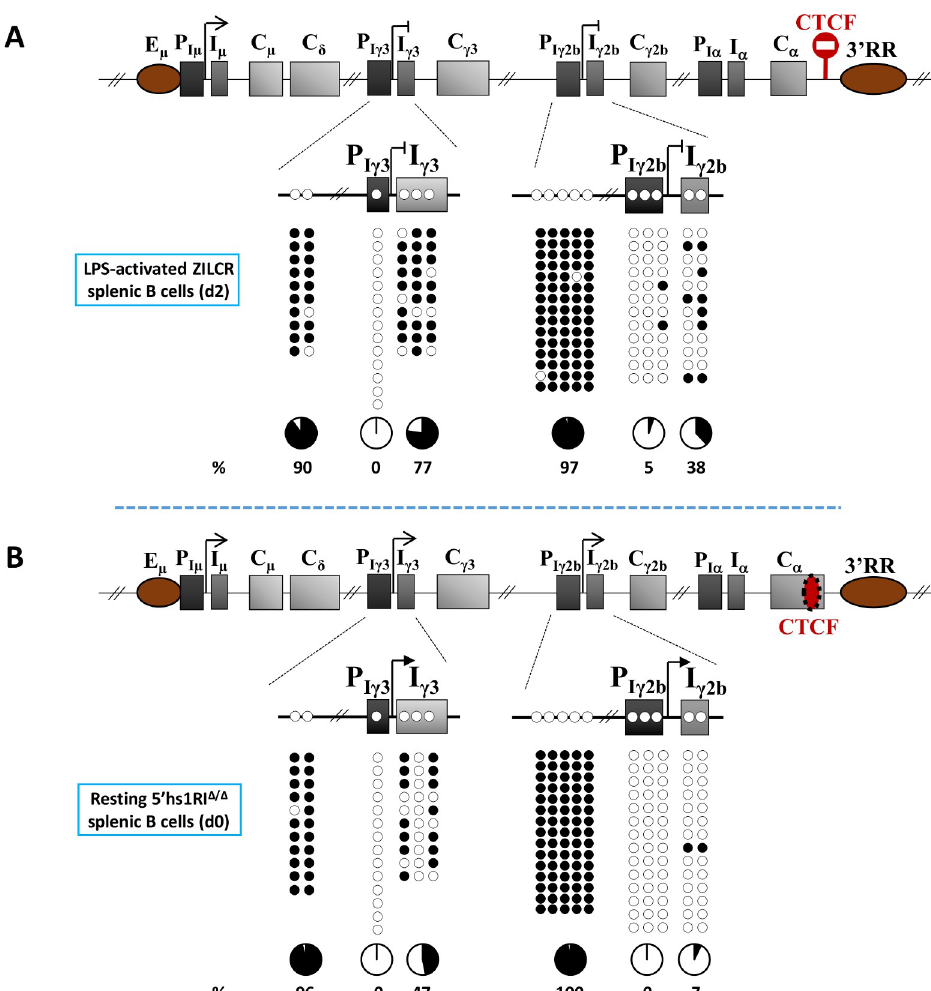
Fig 2. DNA methylation and transcriptional activity of I γ 3 and I γ 2b promoters. (A) The upper scheme indicates the insertion site of the ectopic CTCF insulator (in red) right upstream of the 3’RR (ZILCR mouse line). The insertion results in a complete shut-down of I γ 3 and I γ 2b promoters upon LPS stimulation. The panels report the results of bisulphite sequencing (d2 post-LPS stimulation). (B) The upper scheme indicates the deletion of the endogenous CTCF insulator within α constant gene (dotted red oval) (5’hs1RI mouse line). The deletion results in a constitutive activity of I γ 3 and I γ 2b promoters in resting B cells. The panels show the results of bisulphite sequencing on CD43 - sorted splenic B cells